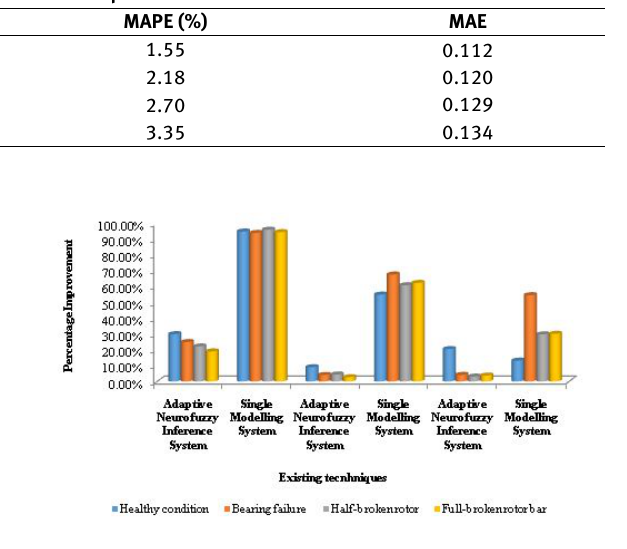
Table 3: Different parameters obtained for four different scenarios by the proposed method Different Scenarios